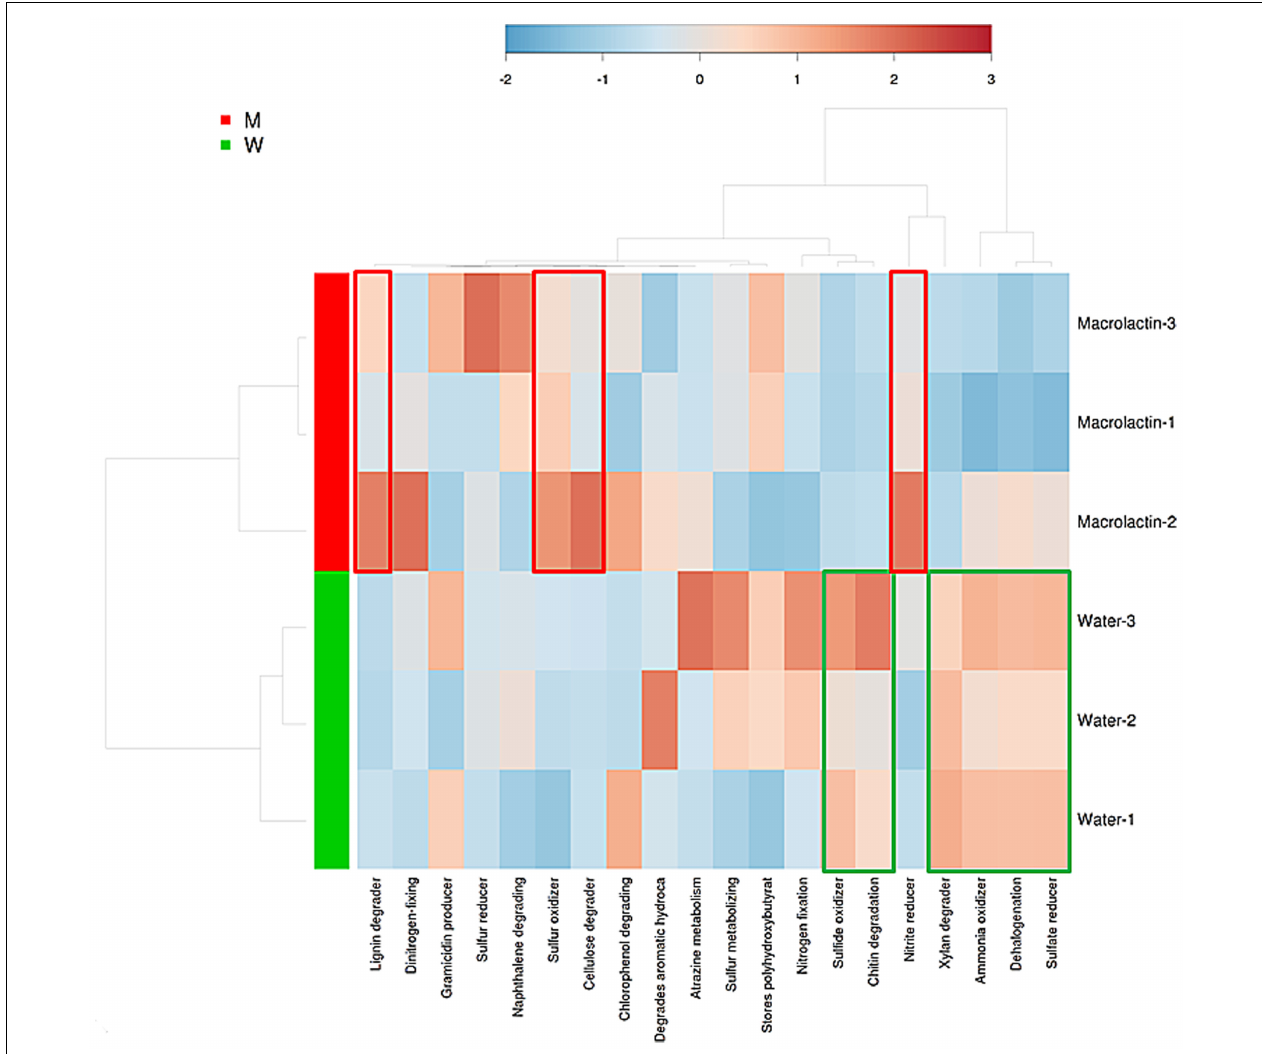
FIGURE 3 | Heatmap analysis of taxonomic to phenotypic mapping of the 16S rRNA sequenced genes between macrolactin treated soil and water control soil generated using METAGENassist.